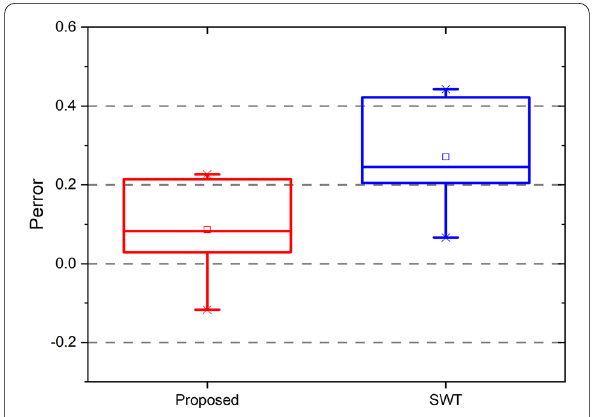
Figure 15 Prediction error of GCr15 under torsion test